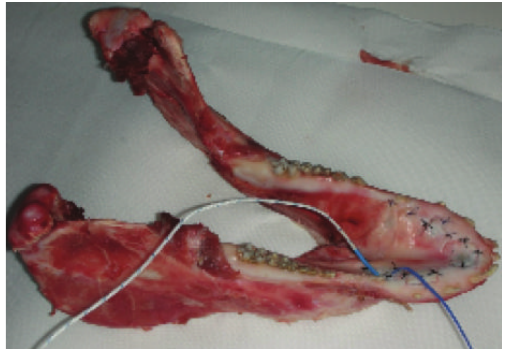
Figure 2: The two thermocouples inserted: one in the bone and the other in contact with the implant.